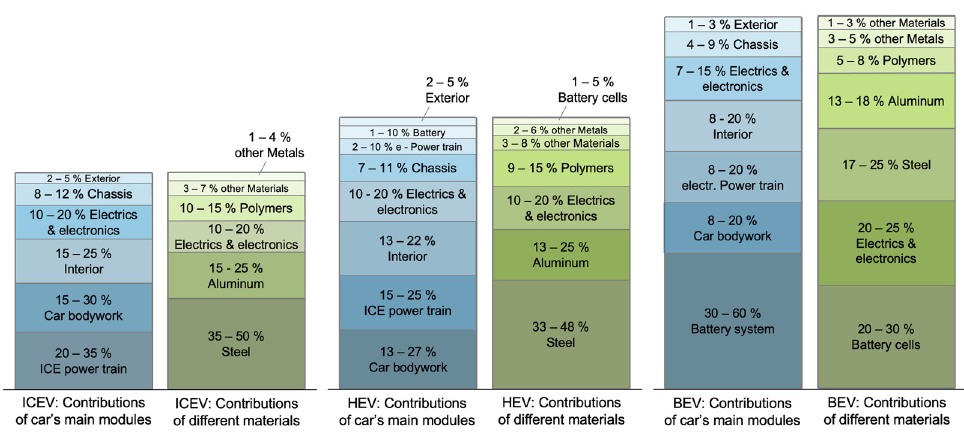
Figure 6. Contributions of main modules and different materials to CO 2 -equivalent emissions of vehicle production.